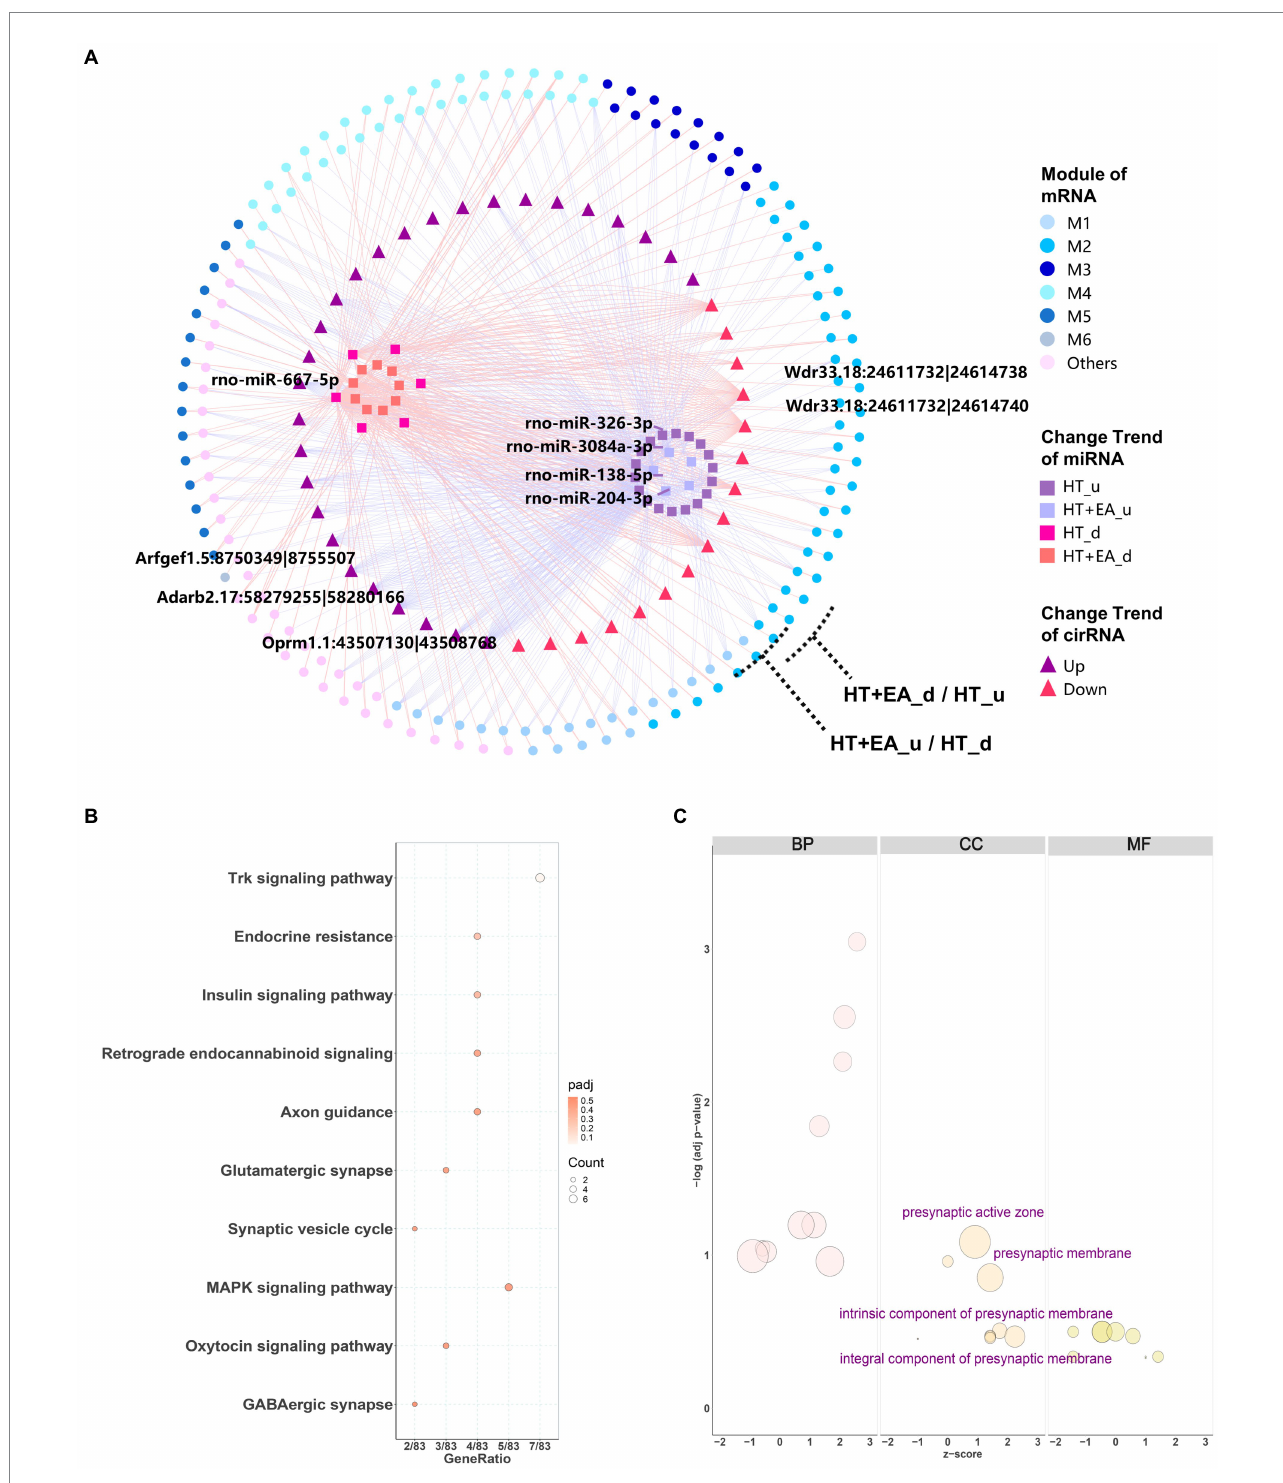
FIGURE 6 Interaction network and functional enrichment analysis of ncircRNA. (A) The circRNA-miRNA-mRNA interaction network showing circRNAs distributed among the six gene modules was composed of 44 circRNAs (squares), 38 miRNAs (triangles), and 399 mRNAs (circles). The top 5 weighted circRNAs and miRNAs were labelled based on their degree of connectiveness. (B,C) KEGG and GO functional enrichment analysis of circRNA-targeted